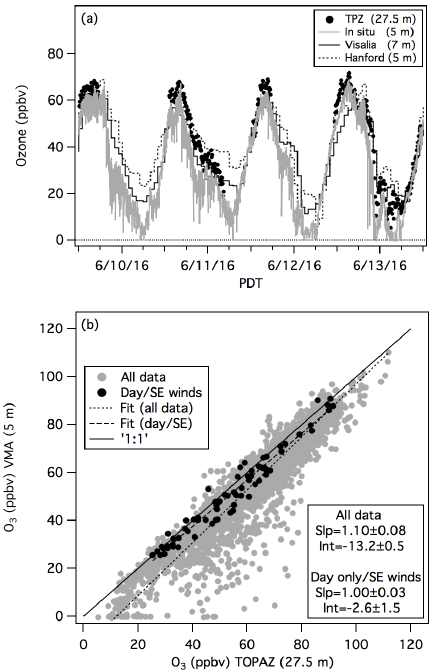
Figure 4. (a) A 4-day time series (9–13 June) showing the O 3 con- centrations in air sampled 5ma.g.l. above the TOPAZ truck at the VMA (gray line) and the O 3 mixing ratios at a height of 27 . 5 ± 5m and distance of 815 ± 15m retrieved from the TOPAZ measurements (filled black circles). The solid black and dotted staircase lines show the 1h measurements from the Visalia and Hanford regulatory mon- itors. (b) Scatterplot comparing the 27.5m TOPAZ measurements to the interpolated 5m in situ measurements. The filled gray circles (with dotted ODR fit) show the entire CABOTS dataset from Fig. 3, and the filled black circles (with dashed ODR fit) show only those measurements made during the day (09:00 to 18:30PDT) when the winds were southeasterly (125 to 145 ◦ ) and greater than 2.5ms − 1 . The solid line shows the 1 : 1